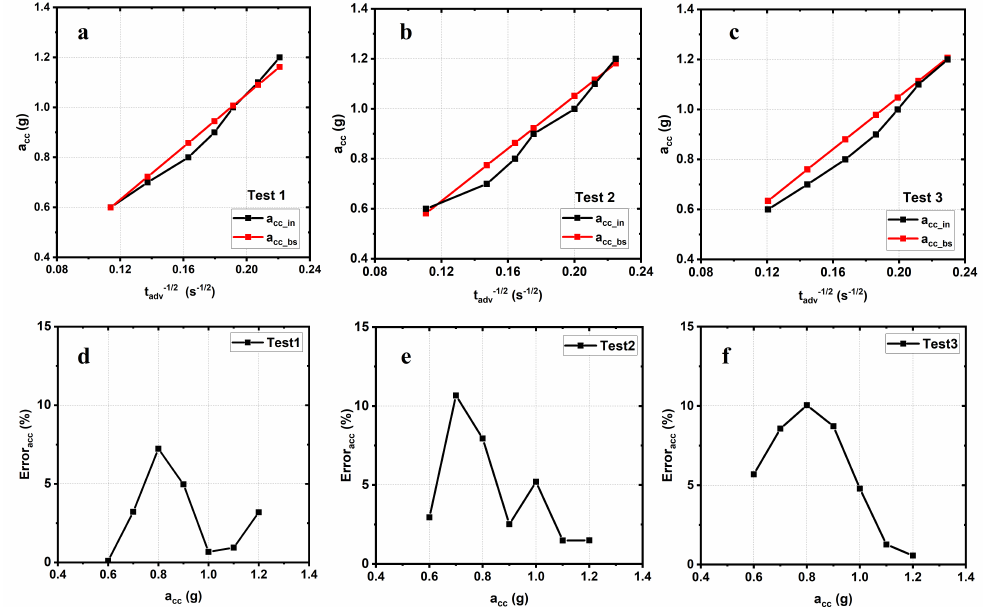
Figure 10. ( a – c ) a cc _ in and a cc _ BS vs. t − 1/2 for three tests to study reproducibility. ( d – f ) Measurement adv of corresponding Error acc vs. the input acceleration a cc _ in for three different tests.